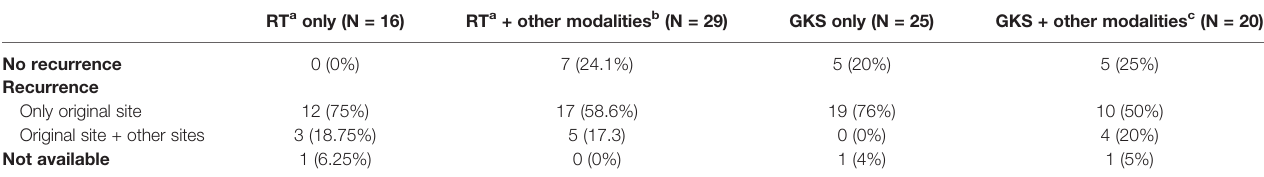
TABLE 5 | Location of second CNS recurrence after treatment.